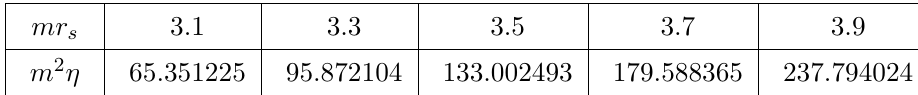
Table 2 . The coupling parameter m 2 (cid:17) with mM = 1 : 5 and various mr s .